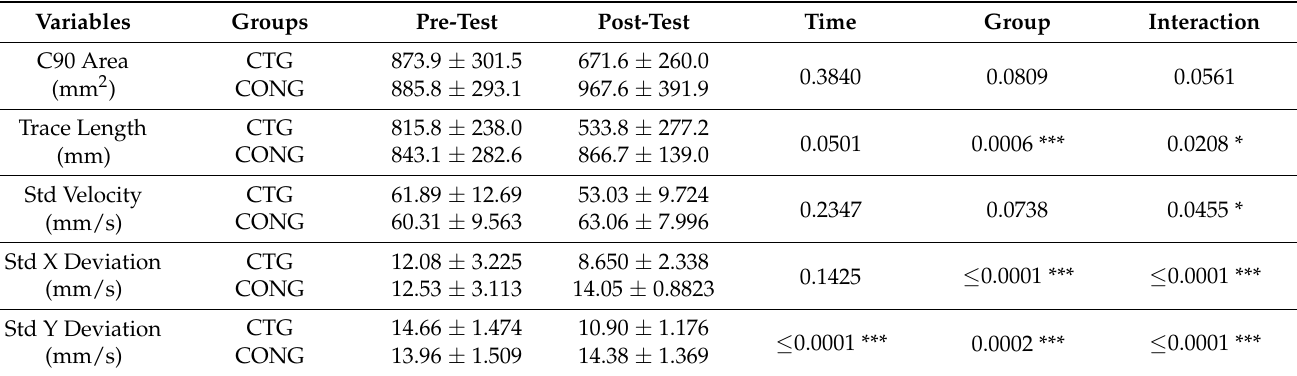
Table note: CTG (n = 20), CONG (n = 20), * means p ≤ 0.05, *** means p ≤ 0.001. Table 7. Comparative analysis of various indicators of static balance ability before and after the experiment with eyes open and left foot standing (LEO).